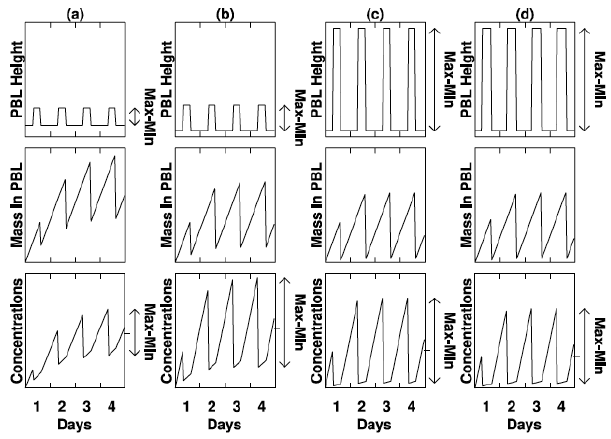
Fig. 10. Boundary layer height and concentrations calculated using our one dimensional model, as described in section 5.1. Top panels show four variations of diurnal cycle of boundary layer height over four days. Middle panels show four days of changes of total 222 Rn in the boundary layer assuming a constant source from the bottom. Bottom panels show mixing ratio in the boundary layer assuming homogeneous mixing ratio in the boundary layer and entrainment of free tropospheric air during growing period only. From left to right, four cases are selected to show the relative change of con- centration in a day to the change of diurnal variations of boundary layer height. The concentrations in the boundary layer were calcu- lated using Eq. (3). See text for